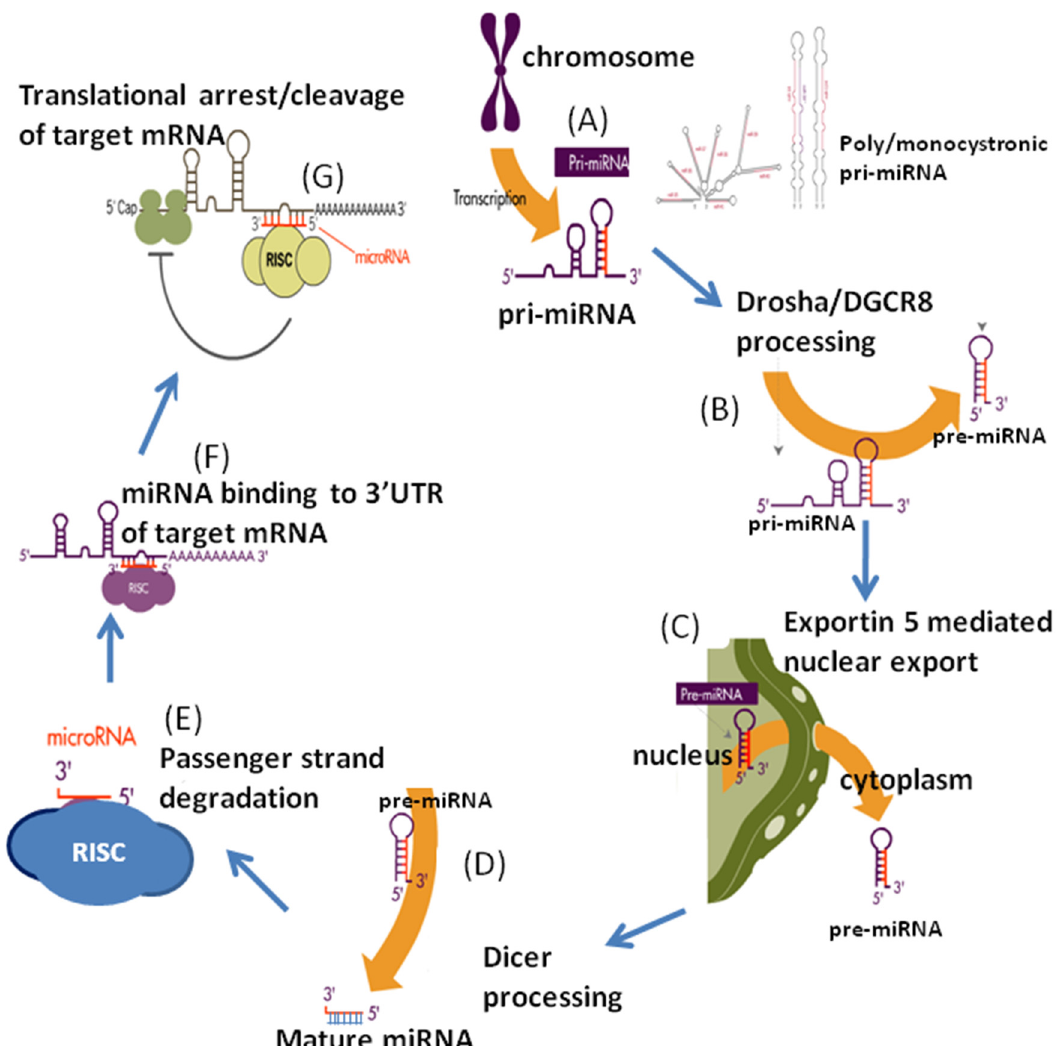
Figure 1. Biogenesis of microRNAs. ( A ): Transcription of primary microRNAs (pri-miRNAs) by RNA polymerase II in the nucleus; ( B ): Pri-miRNA is processed by Drosha and DGCR8 to form a precursor-miRNA (pre-miRNA) approximately 70 nucleotides in length; ( C ): Pre-miRNA is exported to cytoplasm by exportin 5; ( D ): Final processing of pre-miRNA to mature duplex miRNA by RNase enzyme Dicer; ( E ): Incorporation of mature duplex into RNA-induced silencing complex (RISC) where miRNA strand is selectively degraded; ( F ): Binding of complex to the target mRNA guided by mature miRNA; ( G ): Negative regulation of protein translation or degradation of the mRNA transcript based on complementarity of the miRNA to the target sequence. Reprinted with permission from “MicroRNAs as Gatekeepers of Apoptosis”. ( J. Cell. Physiol. 2010 ).